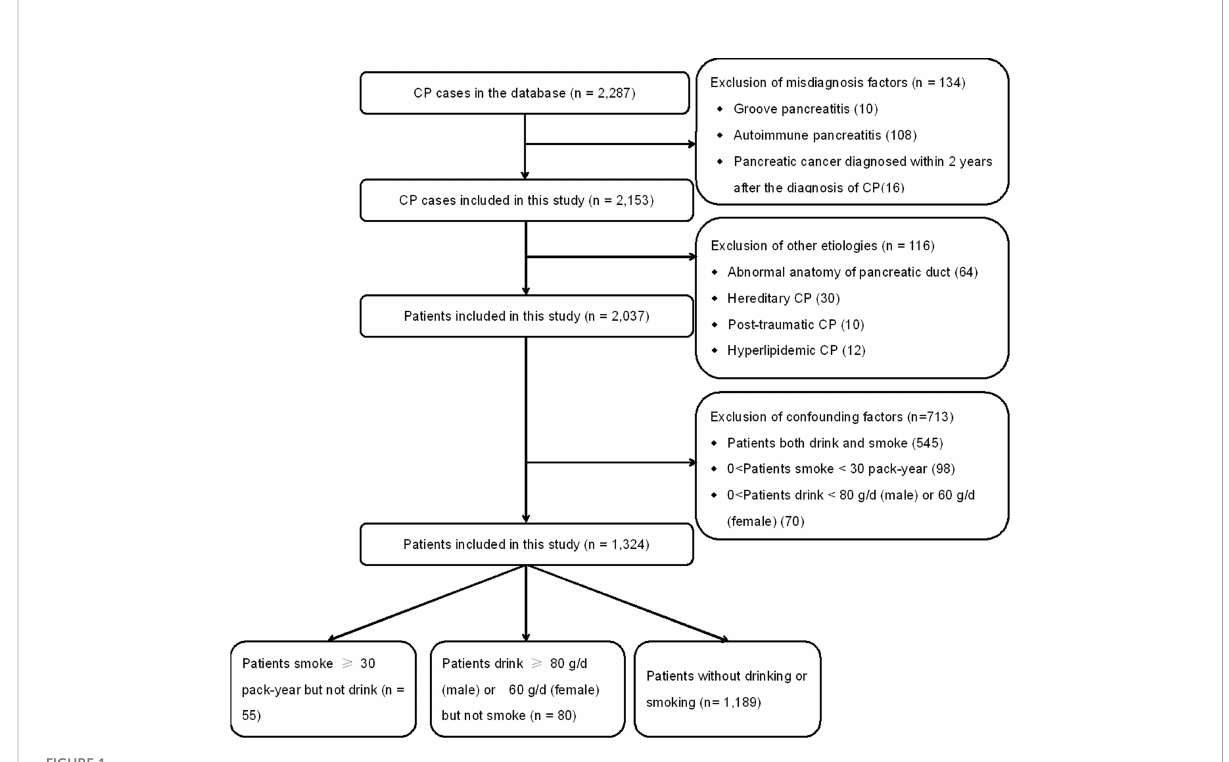
FIGURE 1 Flow diagram of the patients ’ enrollment and study